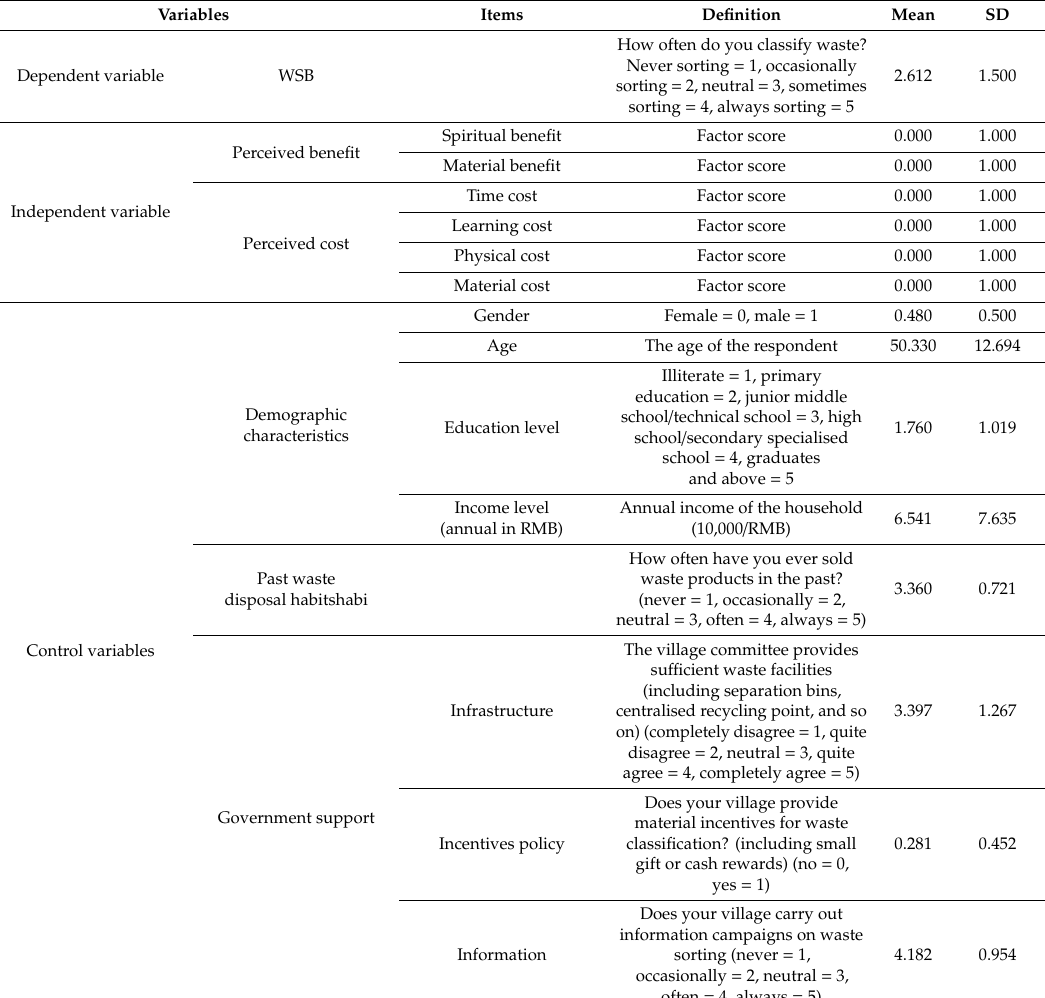
Table 3. Definition and descriptive statistics of control